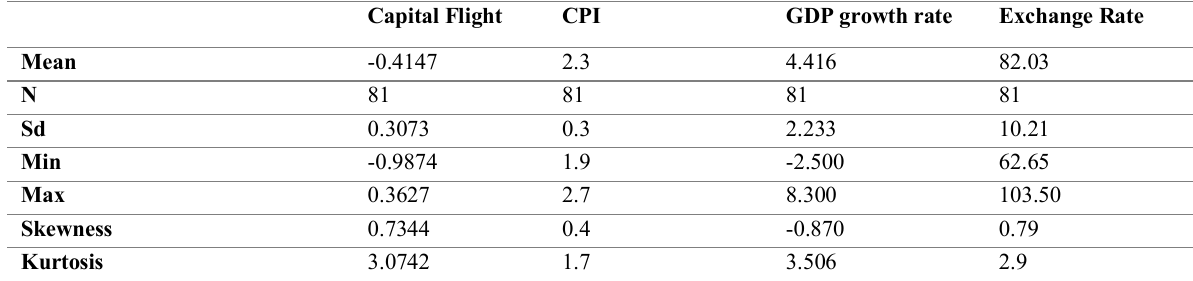
Table 1: Descriptive Statistics of capital flight, CPI, GDP growth rate and exchange